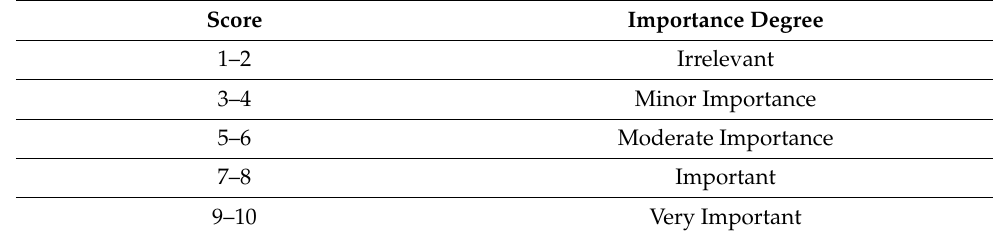
Table 1. Scores assigned to criteria versus importance degree.